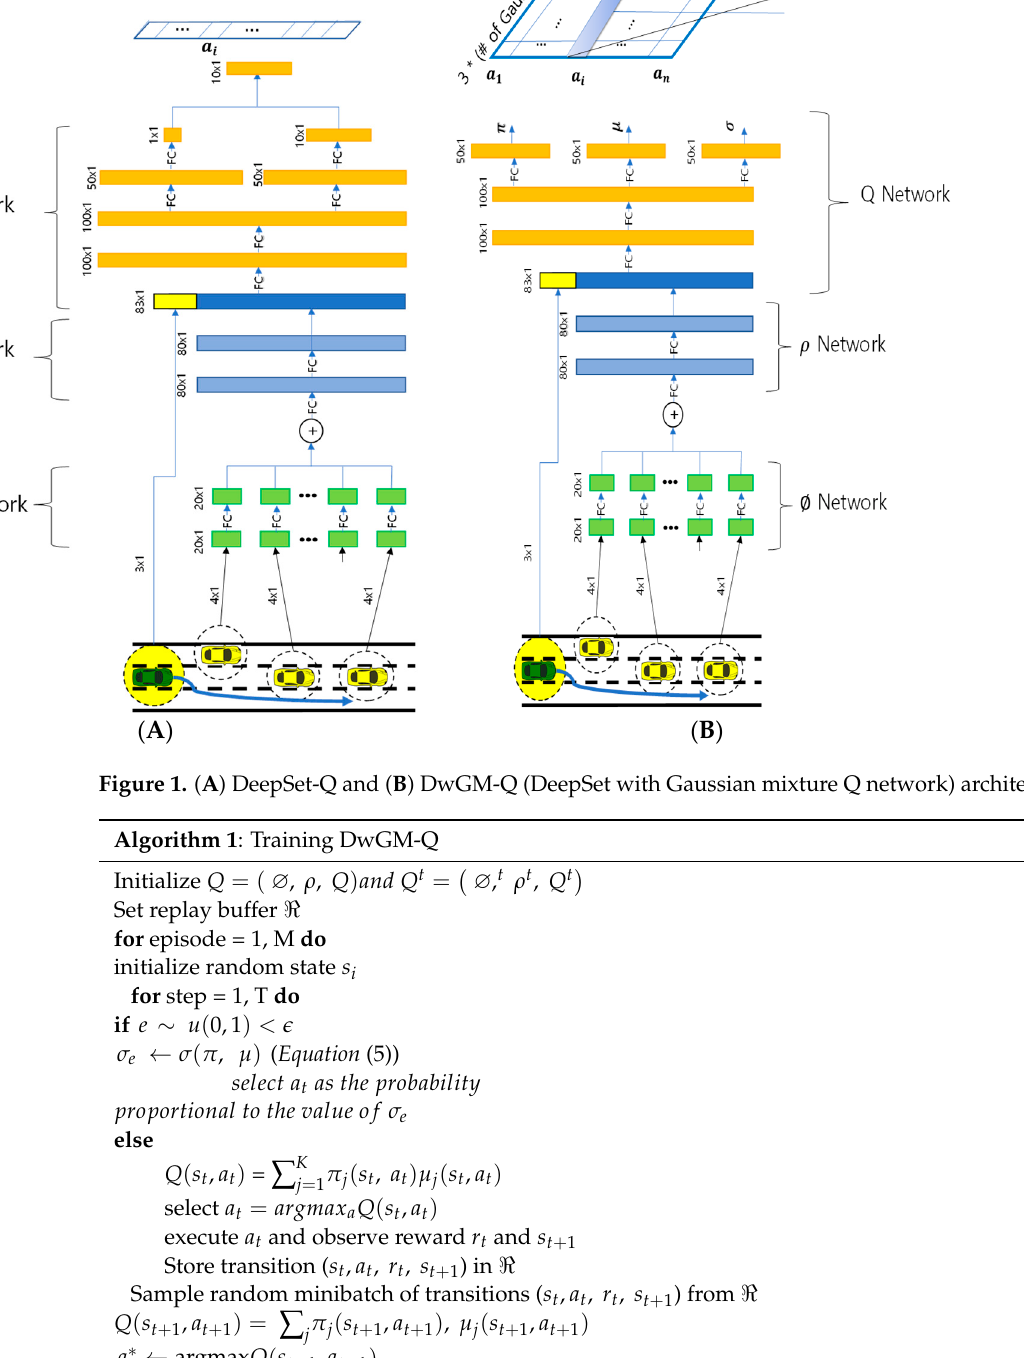
Algorithm 1 : Training DwGM-Q